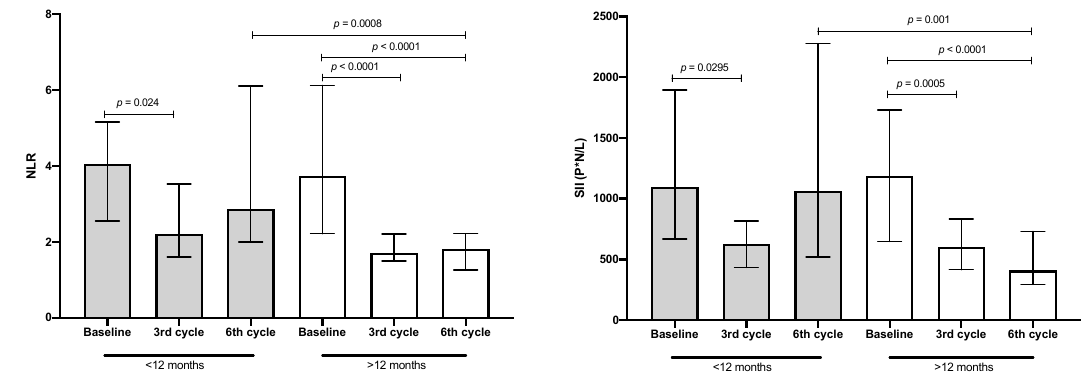
Figure 4. Neutrophil–lymphocyte ratio (NLR) and systemic immune-inflammation index (SII) values during treatment. Median and interquartile ranges are shown ( n = 53).